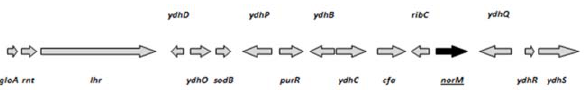
Figure 2. ORFs (arrows) present in the isolated chromosomal